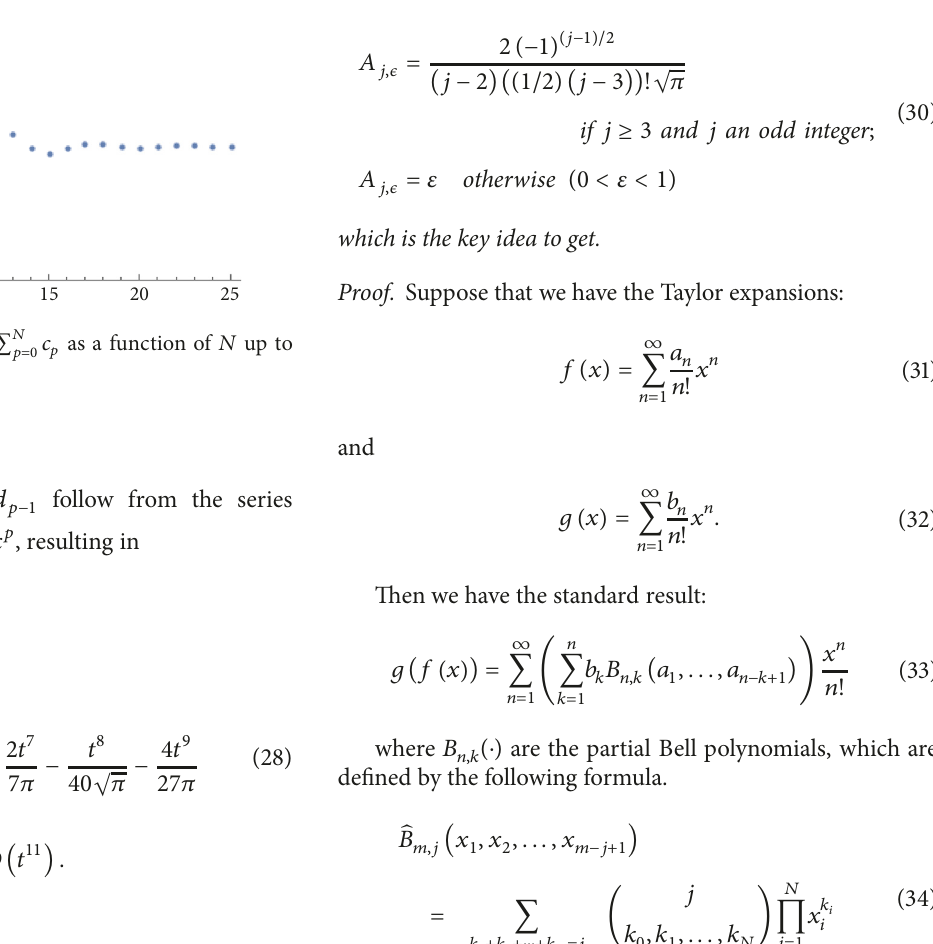
∞ 𝑐 𝑝 seems to converge. See Figure 𝑝=1